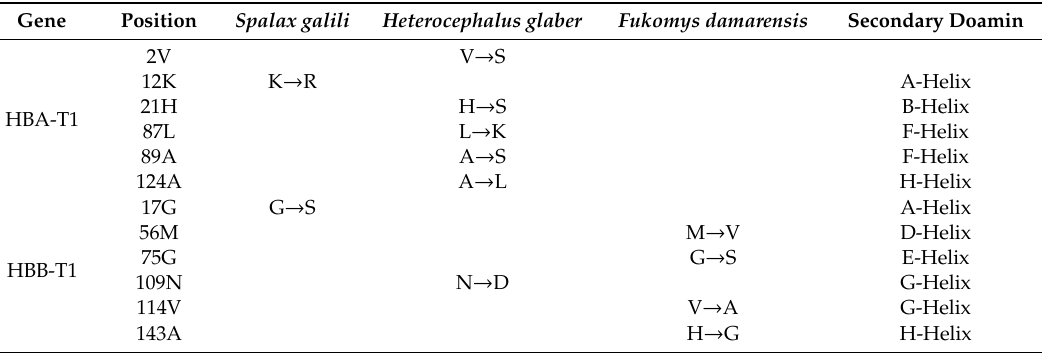
Table 3. Detected positive selection sites in di ff erent helical